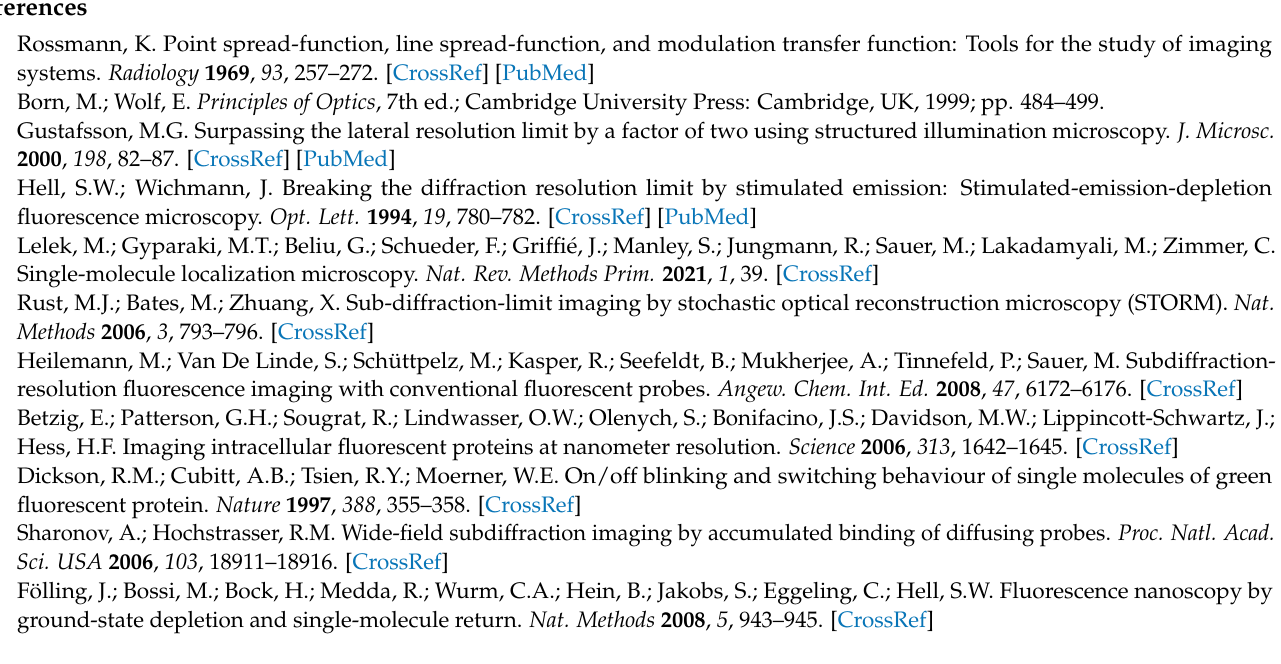
Figure S5: Lacunarity curves and conventionally normalized lacunarity curves of the radiaton treated cells grouped by time after treatment; Figure S6: Lacunarity curves and conventionally normalized lacunarity curves of the chemically treated cells grouped by